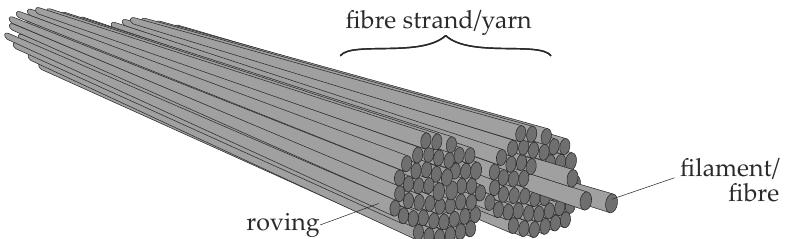
Figure 1. Principal sketch of a larger number of single filaments assembled to a roving and then to a